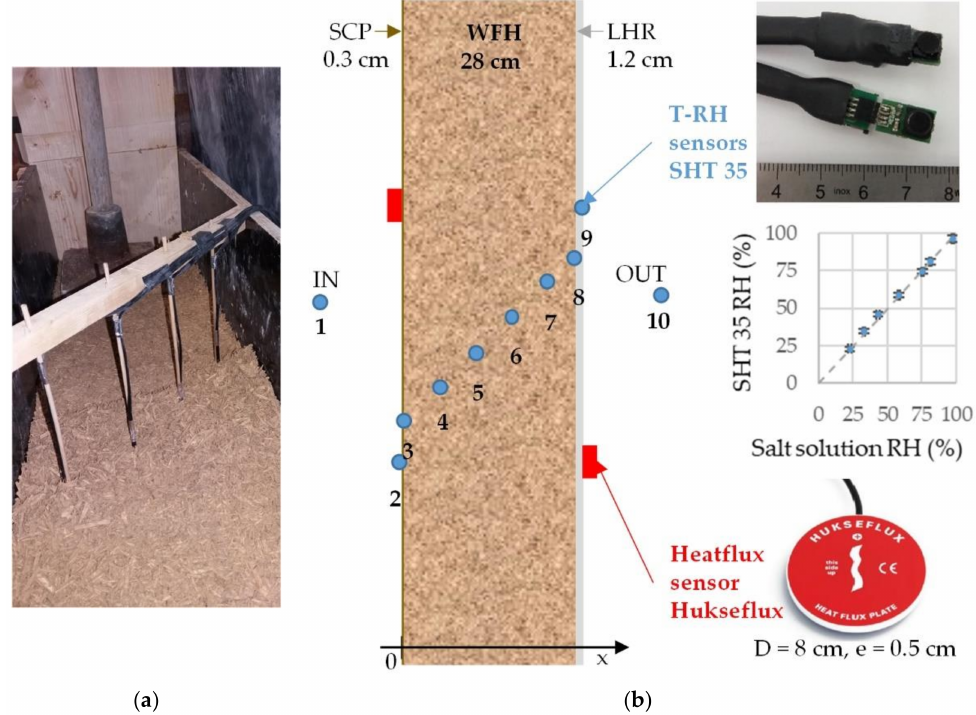
Figure 2. Instrumentation of the wall: ( a ) T-RH sensors implementation during the production of the wall, ( b ) sensors positions, T-RH sensors view and RH response curve, heat flux sensors. Table 1. Experimental sensors’